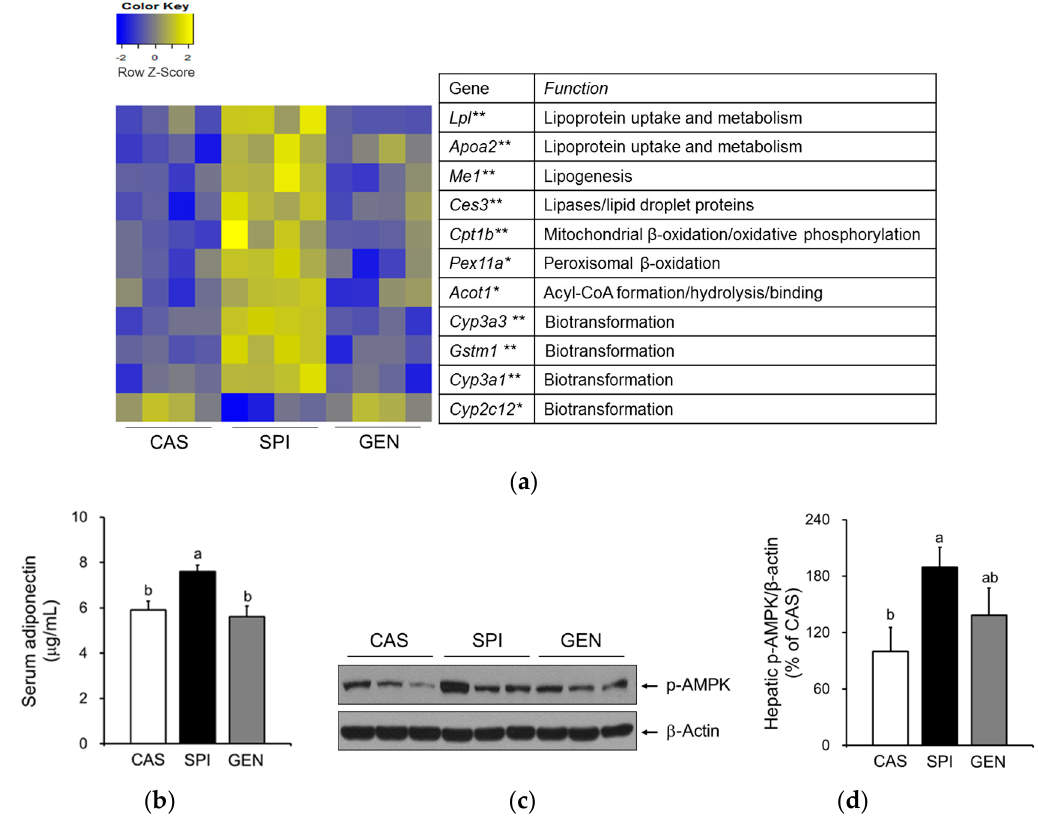
Figure 4. Effects of maternal diet on hepatic expressions of peroxisome proliferator-activated receptor alpha (PPAR α )-target genes of male offspring. ( a ) Visualization of gene expression levels as a heat map. Data were Z-score normalized. Each cell represents the individual differentially expressed genes in each offspring liver sample ( n = 4). Yellow color represents the up-regulated gene expression and blue color represents the down-regulated gene expression. * p < 0.05 and ** p < 0.01 for maternal diet effect among groups; ( b ) Serum adiponectin ( n = 9) was measured by ELISA; ( c , d ) Hepatic phosphorylated AMP-activated protein kinase (p-AMPK) protein levels were determined by immunoblotting ( n = 4–5). Data are means ± standard error of the mean. Means with different superscripts are significantly different at p < 0.05.